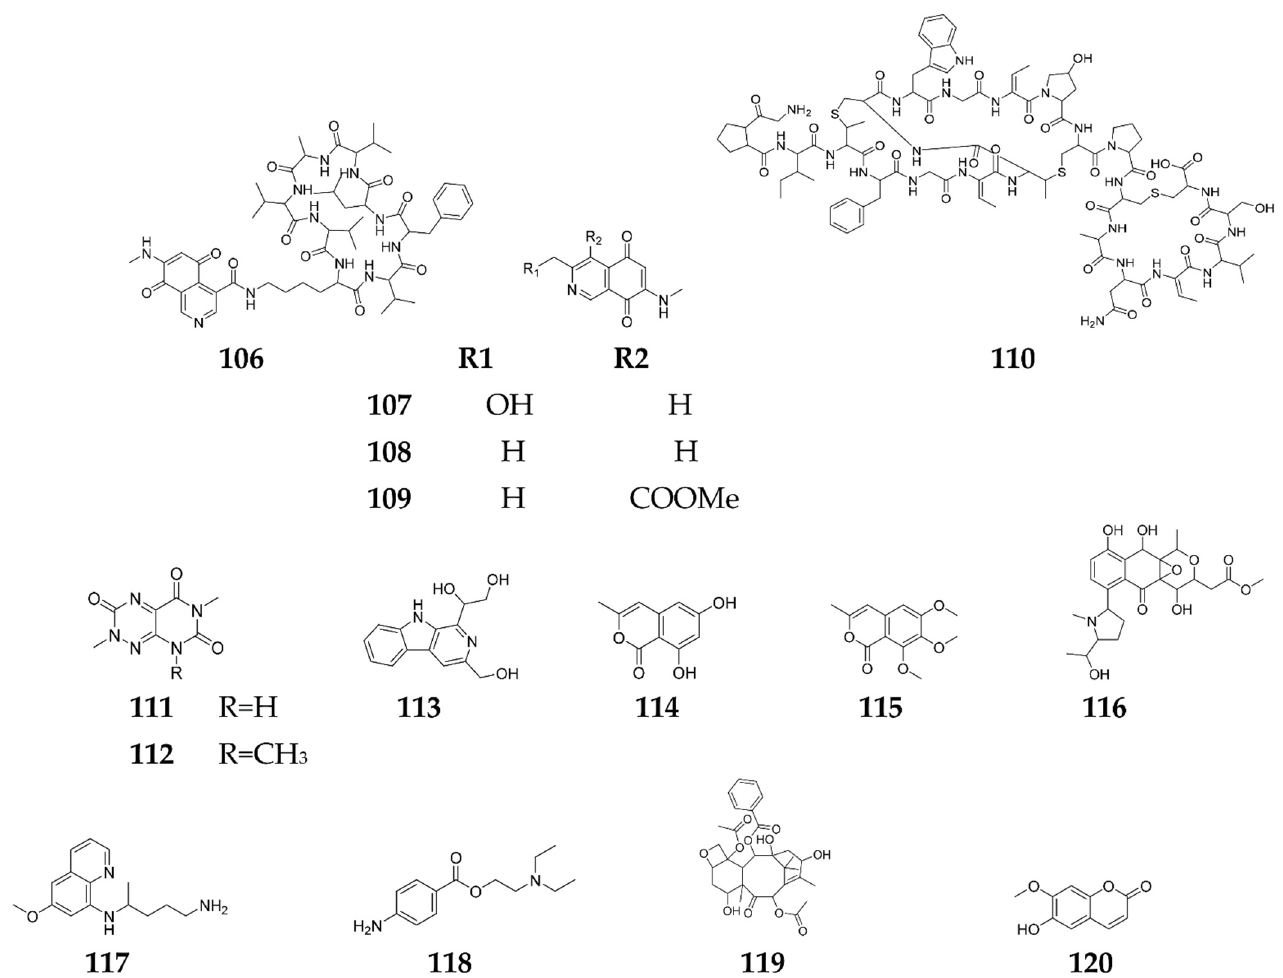
Figure 9. Secondary metabolites elicited by high-throughput screening HiTES.